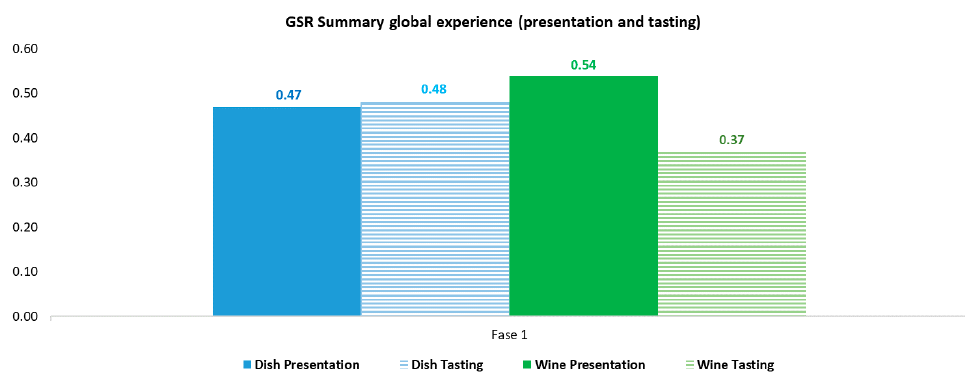
Figure 8. GSR summary analysis of presentation phase and tasting phase for dishes and wines. Source: Original work from the authors.